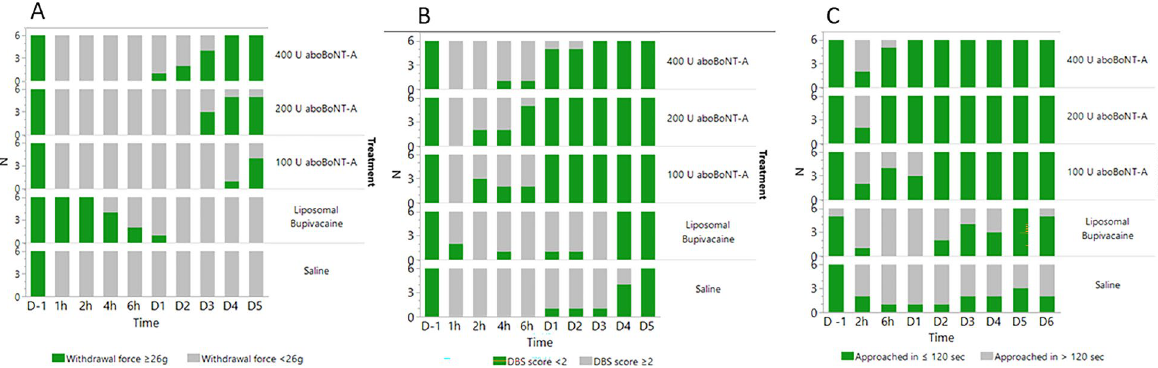
Figure 2. Effects of aboBoNT-A, saline, and liposomal bupivacaine on the number of animals exhibiting postsurgical pain-related versus normal responses in each group. Mechanical sensitivity/withdrawal force ( A ), DBS ( B ) and approaching time ( C ) in animals that received a full-skin and muscle incision and retraction surgery (Day 0), followed by intraoperative treatment with either aboBoNT-A (100 U, 200 U, or 400 U), saline or liposomal bupivacaine (n = 6/group). Panel ( A ) shows the number of animals (N) with normal mechanical sensitivity (WF ≥ 26 g) vs hypersensitivity/allodynia (WF < 26 g). Panel ( B ) shows the number of animals exhibiting moderate to high distress (DBS ≥ 2) vs those with minimal or no distress (DBS < 2). Panel ( C ) shows the number of animals that initiated approach in ≤ 120 s or those that took more than 120 s in the Approaching test. AboBoNT-A, abobotulinumtoxinA; DBS, distress behavior score; U,